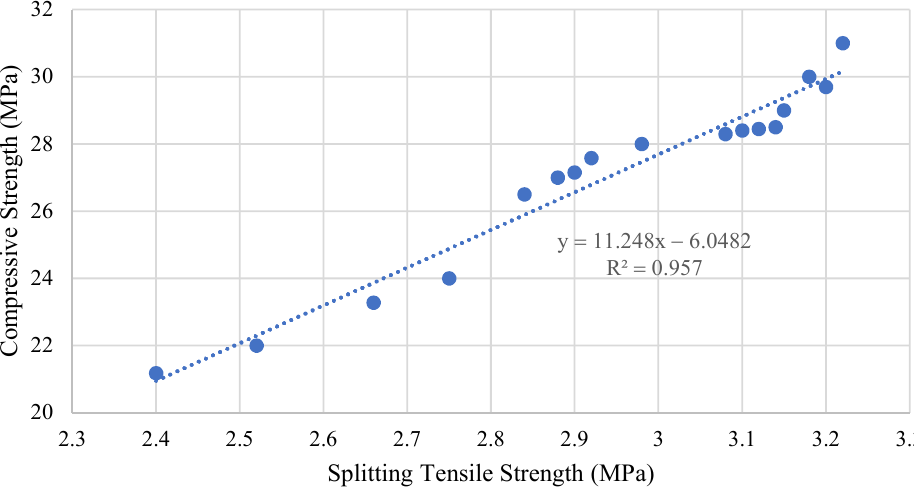
Figure 15. Correlations between the splitting tensile strength and compressive strength of concrete containing CCA and GGBFS together.